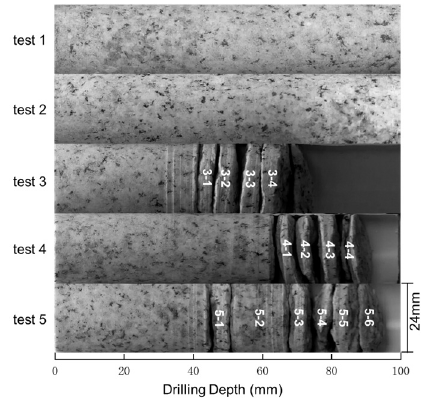
Figure 6. Cores of test 1-5.